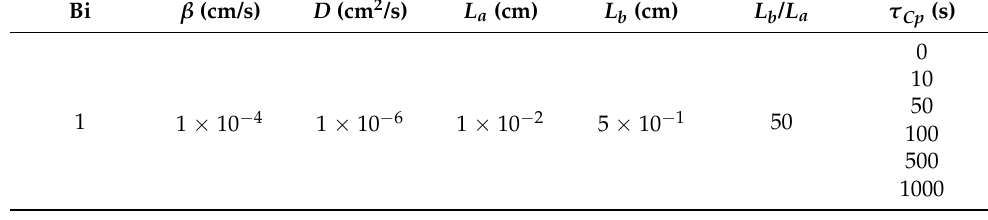
Table 2. Parameters of conductivity relaxation with different τ Cp .